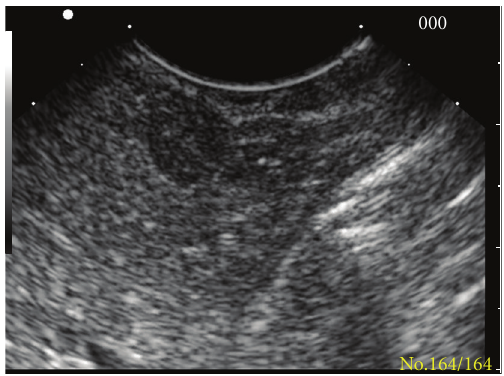
Figure 3: Chromogranin staining of the specimen obtained with fine-needle aspiration. Magnification = 20x.